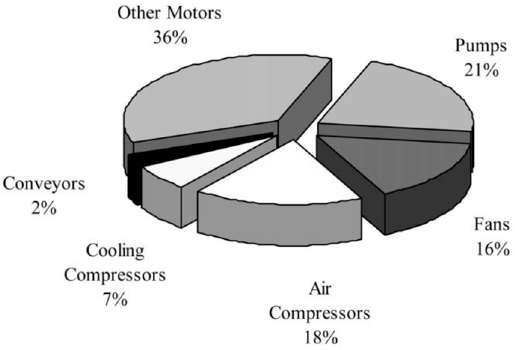
Figure 4. Disaggregation of electric motor use in the European Union (adapted from [40]).